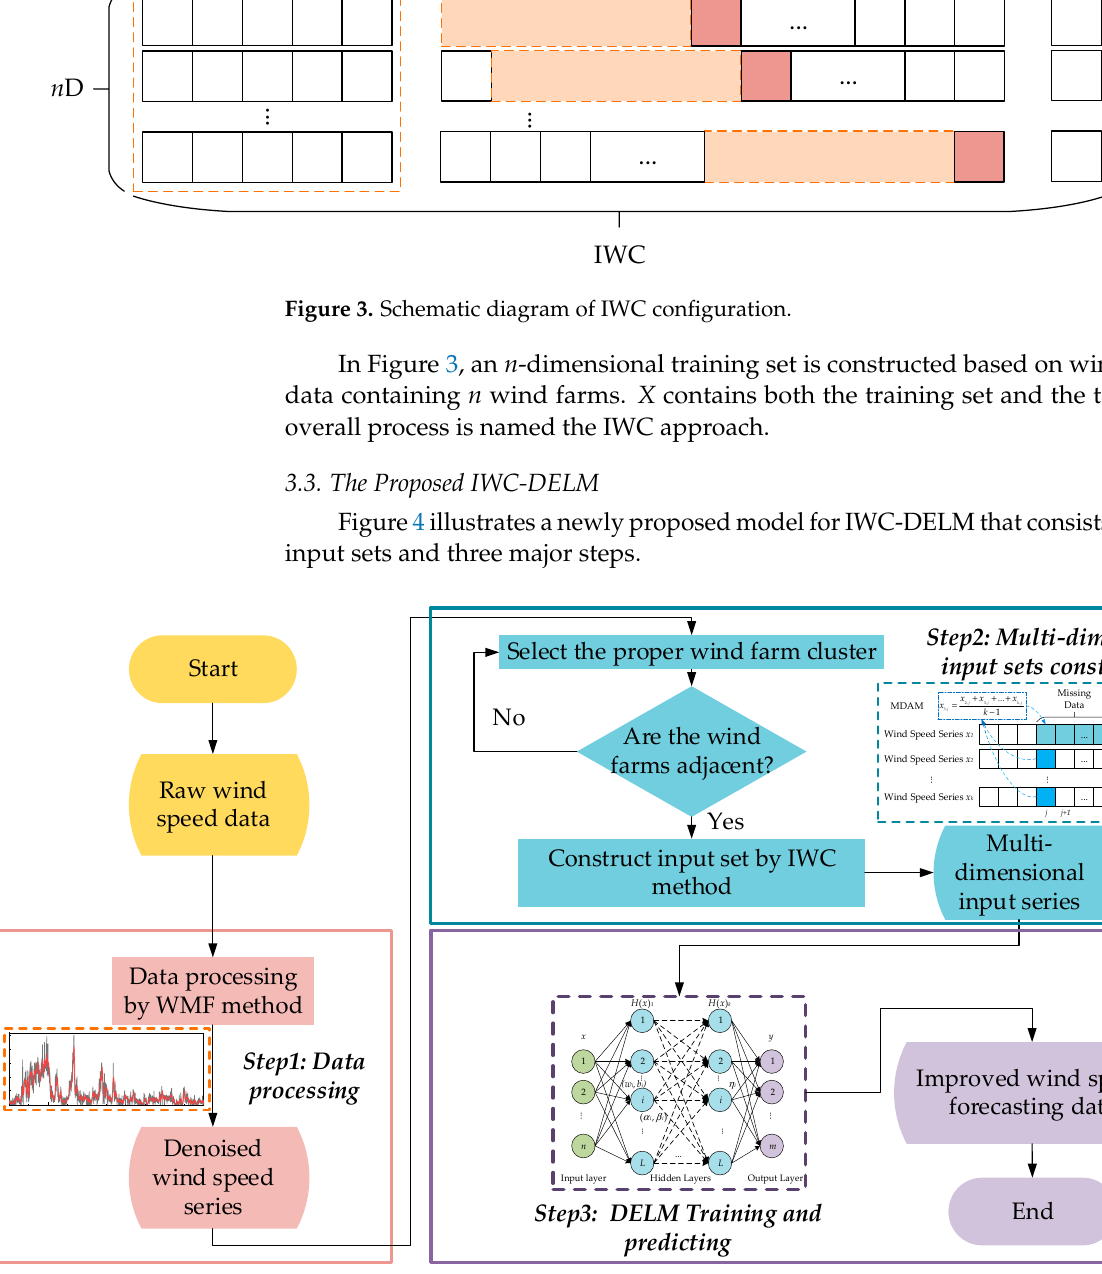
Figure 4. Flowchart of IWC-DELM . Table 1. Configuration of the proposed ensemble model IWC-DELM .